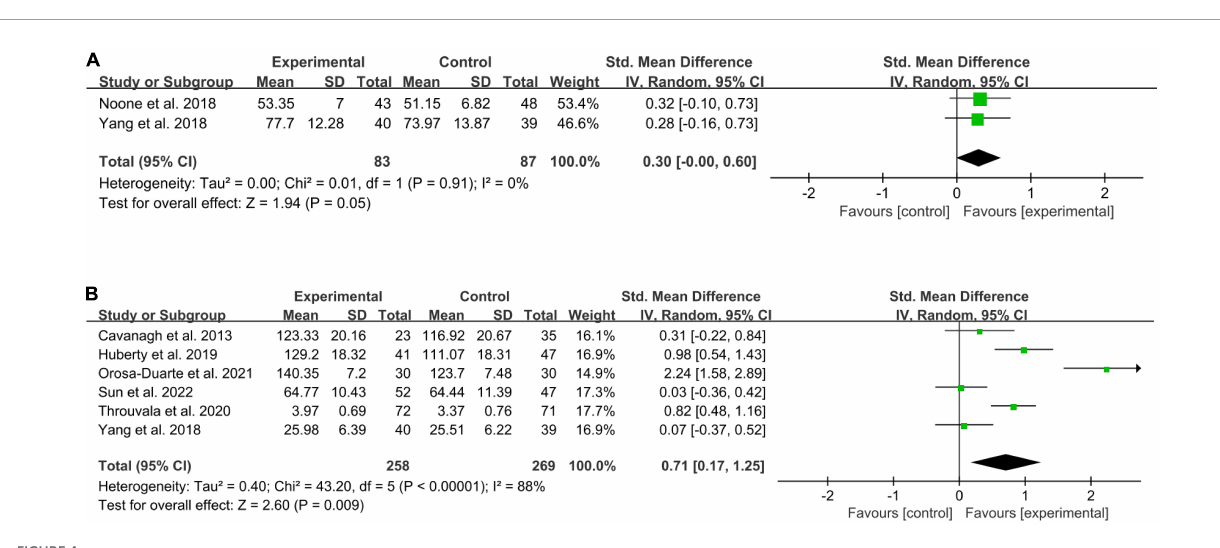
FIGURE4 Forests plot of meta-analysis for the effect of online MBIs on wellbeing and mindfulness. (A) Wellbeing. (B)